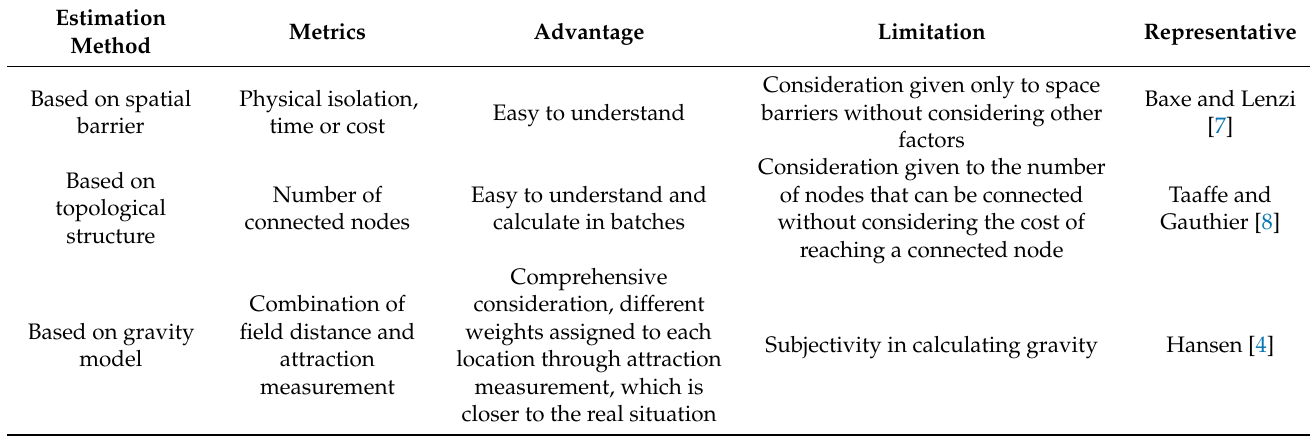
Table 1. Advantages and disadvantages of four types of accessibility estimation